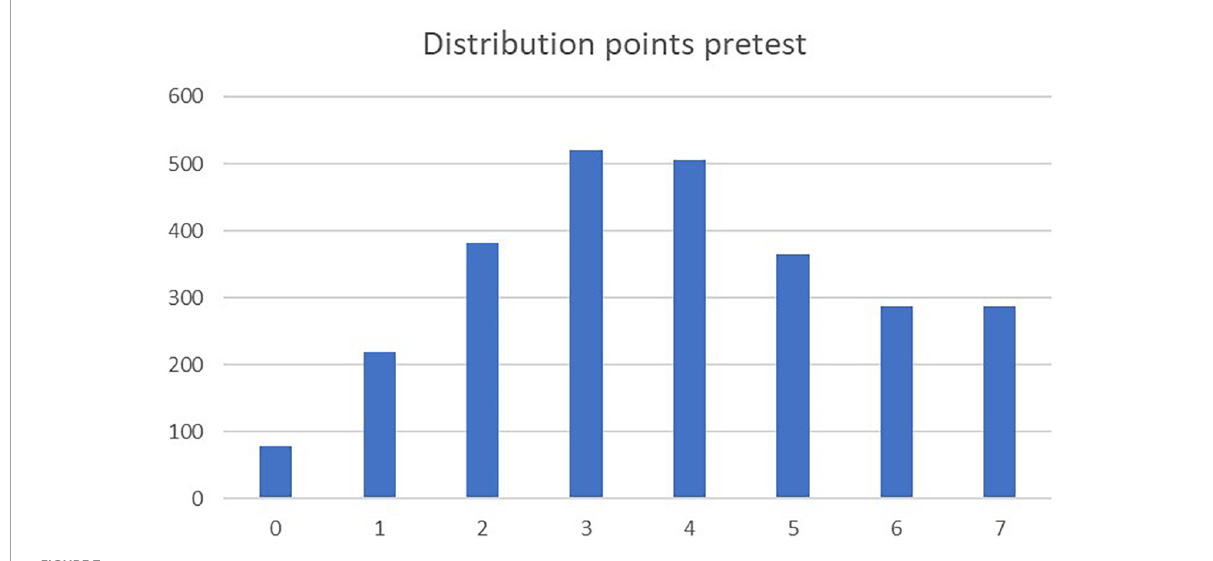
FIGURE7 Distribution points pretest (7 points